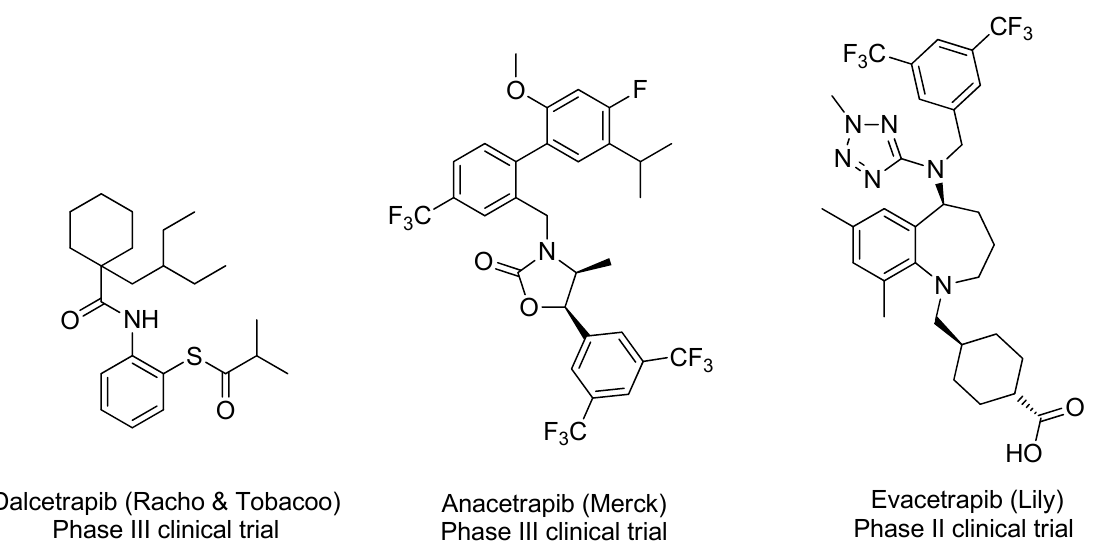
Figure 1. Structures of current CETP inhibitors.